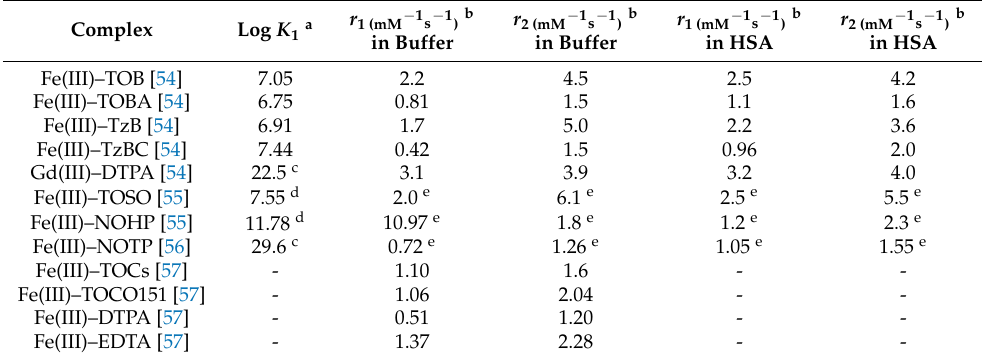
Table 2. Protonation constant (log K 1 ) and relaxivity ( r 1 , r 2 ) for mononuclear Fe(III) complexes with macrocyclic